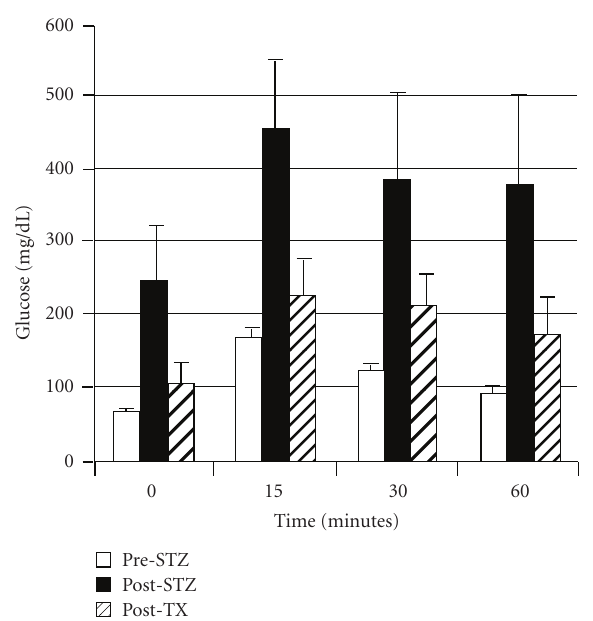
Figure 4: Intravenous glucose tolerance in rhesus macaques. Glu- cose in peripheral venous blood was measured prior to intravenous infusion of dextrose (Time 0) and at several times after infusion in three fasted rhesus macaques either prior to administration of STZ (Pre-STZ), 5 days following administration of STZ (Post-STZ), or 3 months following transplantation of 20–40 E28 pig pancreatic primordia in mesentery of STZ-diabetic macaques (Post-TX). Data are shown as mean ± SE (3 macaques), reproduced with permission